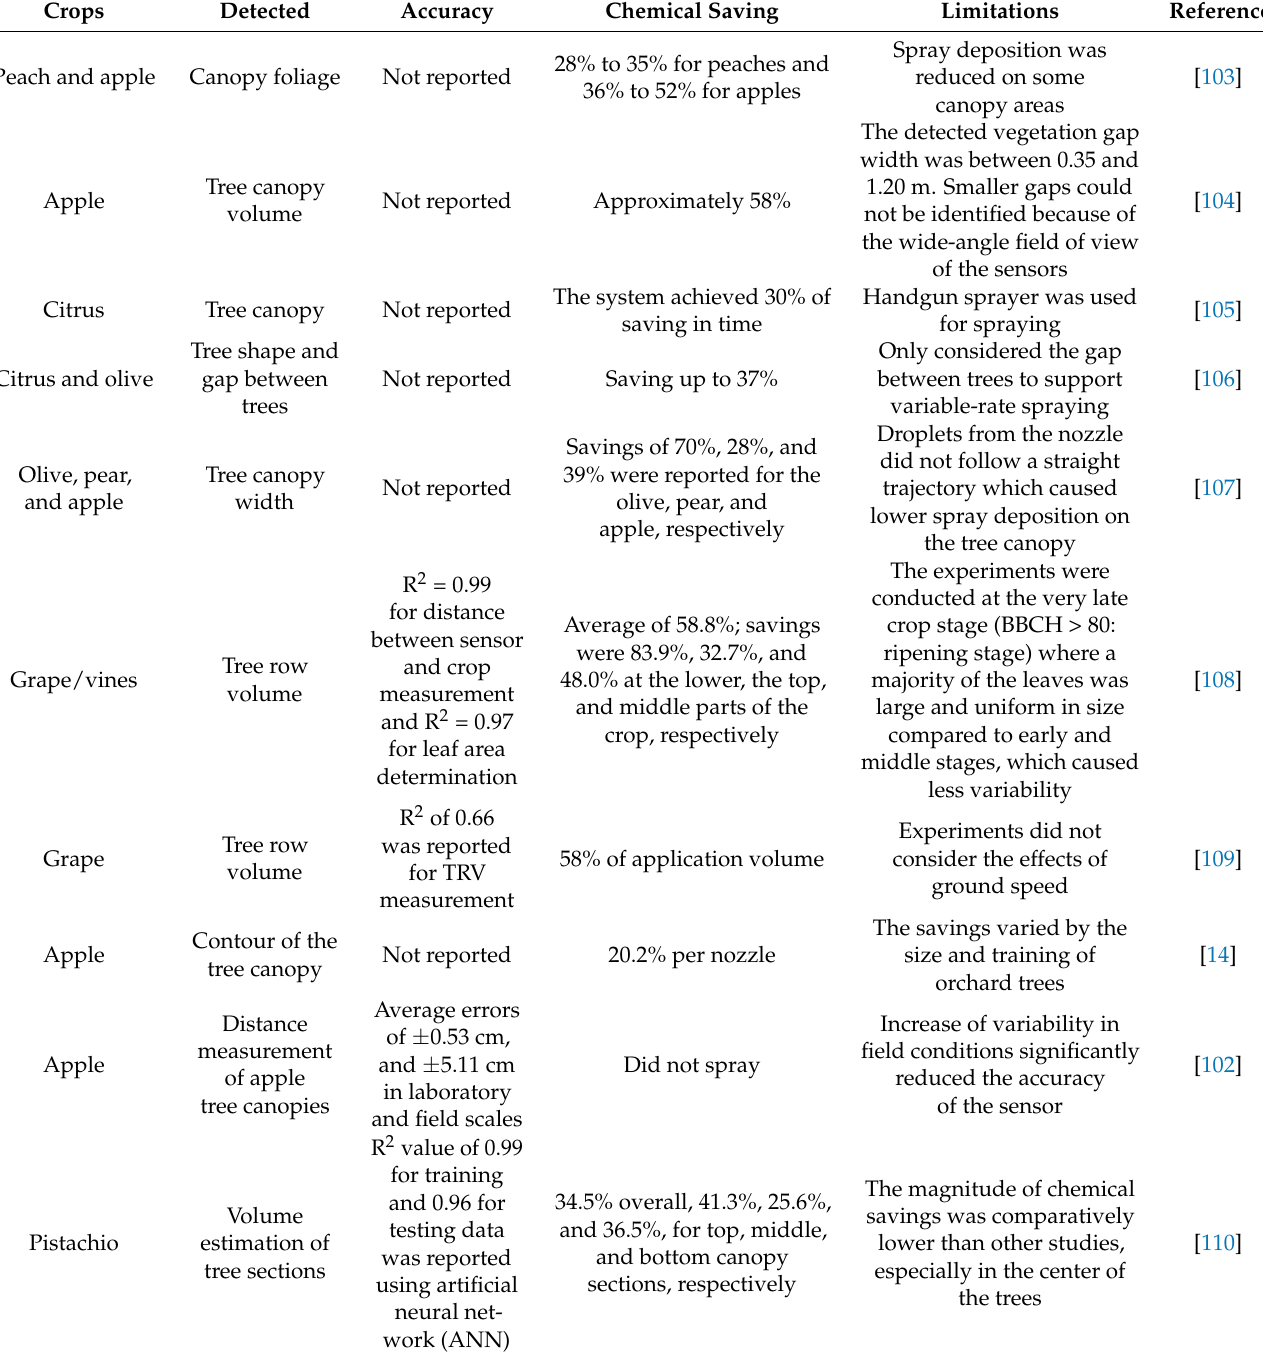
Table 4. Summary of ultrasonic sensor used in precision spraying in